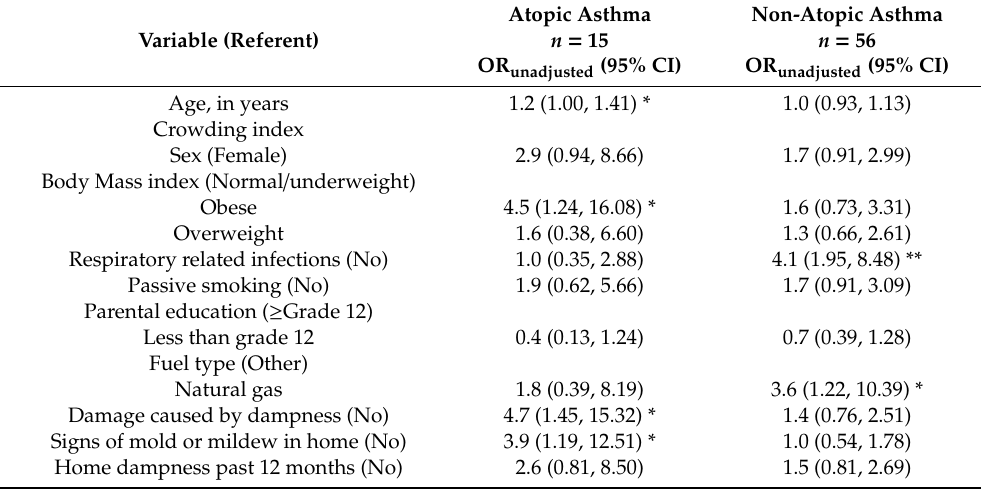
Table 2. Univariate multinomial logistic regression analyses (odds ratio (OR) and 95% confidence intervals (CI)) of variables added to the multivariate analyses assessing risk factors for atopic and non-atopic asthma (referent: no asthma) for 280 First Nation children.